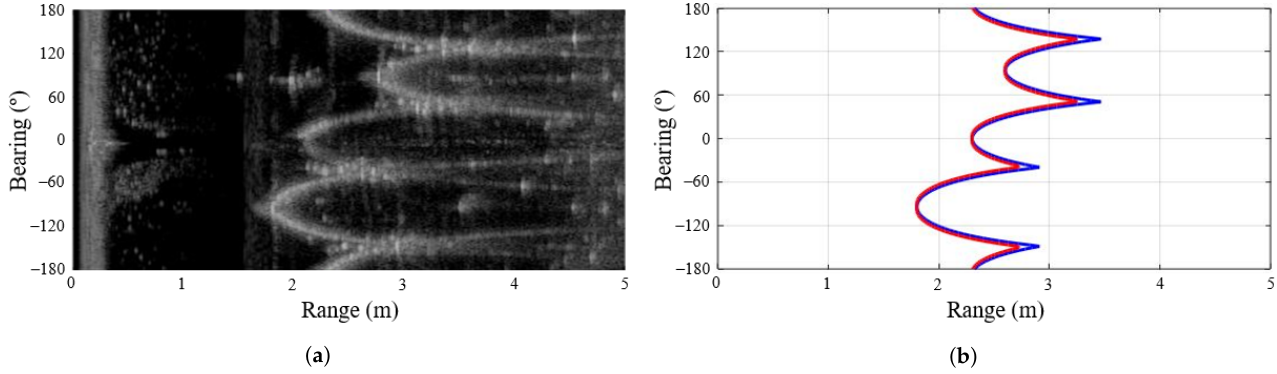
Figure 2. Illustration of challenges portrayed by acoustic image analysis. ( a ) Acoustic image obtained through mechanical scanning imaging sonar from a water tank and ( b ) ideal polar representation of the walls of the water tank (blue) and ideal sonar representation